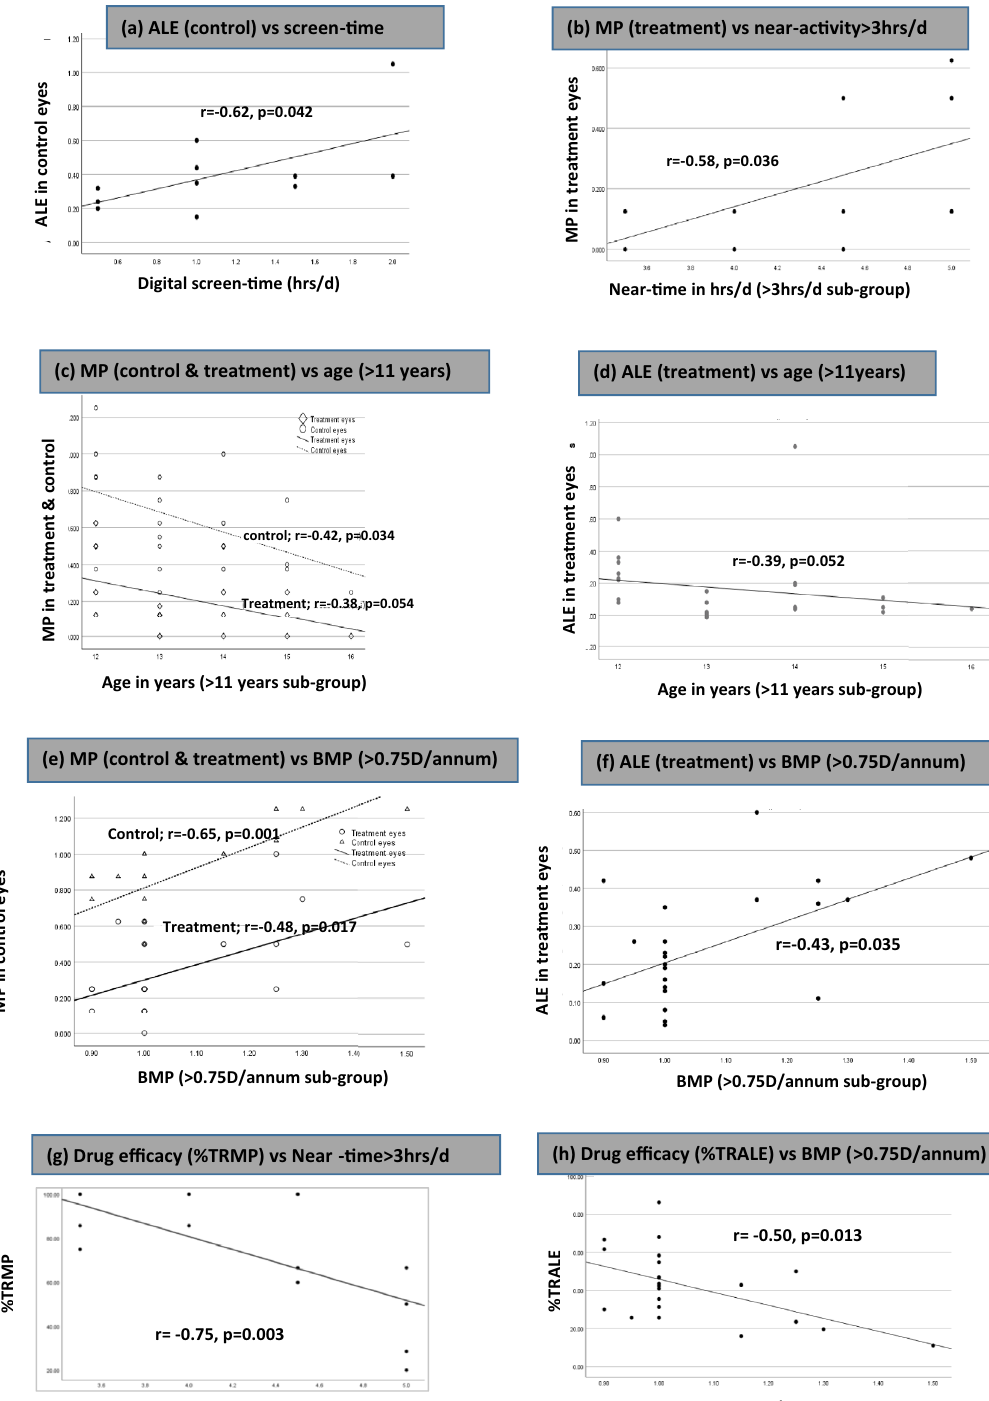
Figure 3. Scatter plot showing correlation of MP, ALE, %TRMP and % TRALE with various sub-groups of modifiable and non-modifiable factors: ( a ) correlation of ALE (control eyes) vs screen time in children using digital devices (upto 2 h/d); ( b ) correlation of MP (treatment eyes) vs near-time in children with near activities > 3 h/d; ( c ) correlation of MP (control and treatment eyes) with age in children > 11 years; ( d ) correlation of ALE (treatment eyes) vs age in children > 11 years; ( e ) MP (treatment and control eyes) versus BMP in children with baseline fast progression (> 0.75 D/annum); ( f ) ALE (treatment eyes) versus BMP in children with fast progression (> 0.75 D/annum); ( g ) %TRMP versus near-time in children spending > 3 h/d; ( h ) %TRALE versus BMP in children with fast progression (> 0.75 D/annum). MP myopia progression, ALE axial length elongation, h/d hours per day, %TRMP percentage total reduction in myopia progression, %TRALE percentage total reduction in axial length elongation, D dioptre, BMP baseline myopia